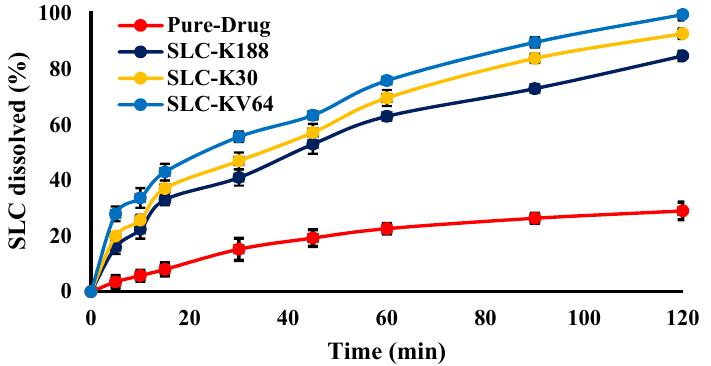
Figure 6. In vitro release profile of pure SLC, SLC-K188, SLC-K30, and SLC-KVA64. Table 1. Similarity factors and release kinetics of prepared SDs.